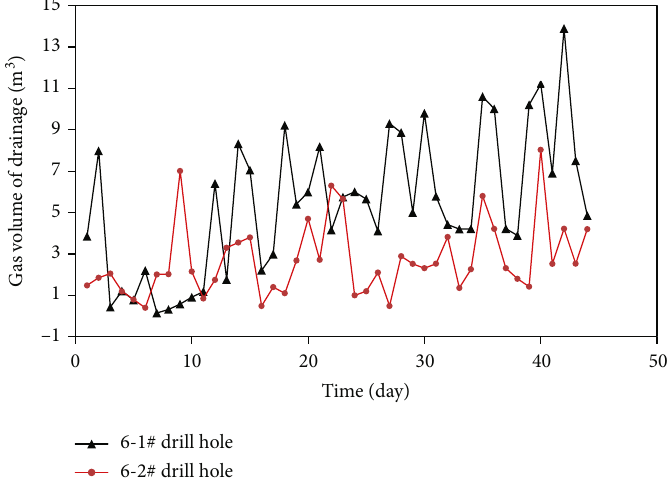
Figure 11: Gas extraction in the borehole group 6#.